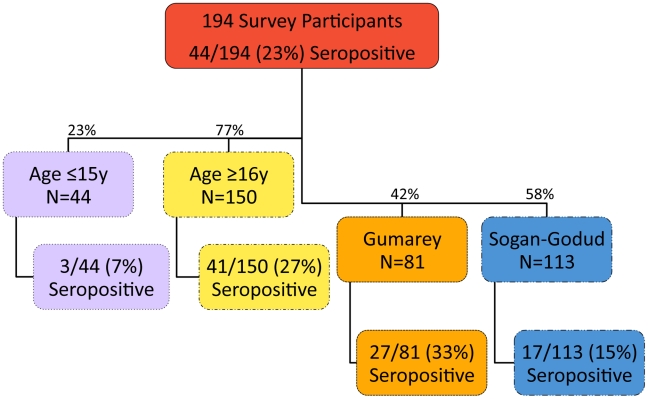
Flow chart of study samples.